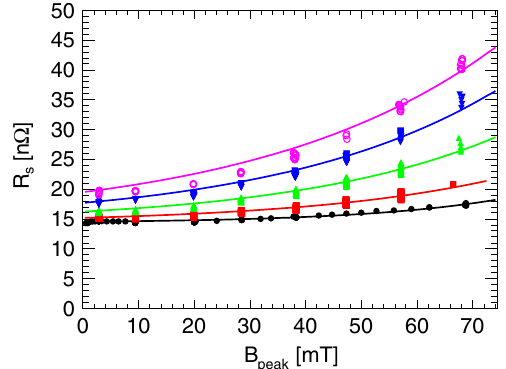
FIG. 6. Temperature dependent surface resistances as a function of the rf field. The corresponding temperatures are 2.4, 3.0, 3.5, 4.0, and 4.5 K from the bottom. The solid line shows the best empirical fitting at each